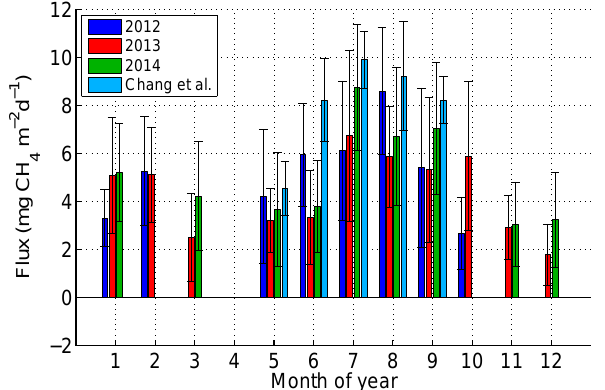
Figure 9. Average Alaska monthly CH 4 fluxes for 2012 (blue), 2013 (red), and 2014 (green), estimated based on a uniform Alaska- wide flux scaled to monthly mean observations at the CRV tower. Light blue bars indicate monthly fluxes derived from 2012 CARVE aircraft observations, with error bars representing the 68% confi- dence interval (CI) (calculated by dividing the 95% CI by 1.96) from Chang et al. (2014). Error bars on the tower-derived fluxes are based on propagating background uncertainty (1 σ ; Sect. 3.3) and uncertainty derived from a sensitivity analysis on the altitude of the model runs (Sect. 3.2) only. Months for which fluxes were based on 6 or fewer days were eliminated from the